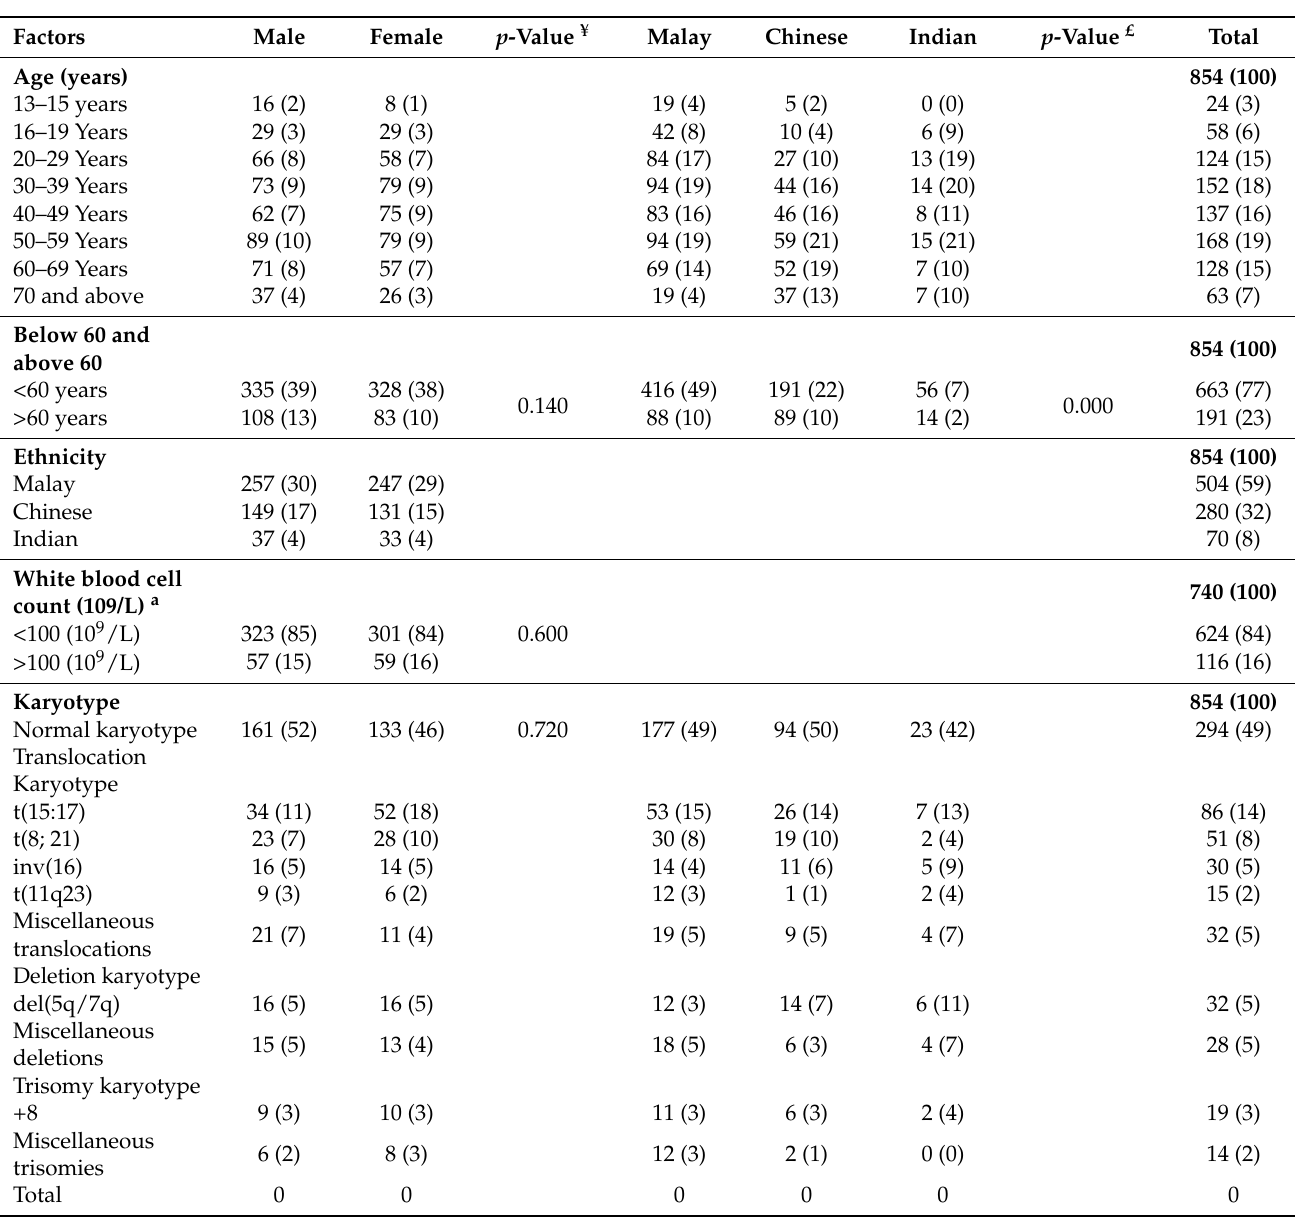
Table 1. The distribution of cytogenetic profiles based on gender, age, group, and ethnicity are depicted in Figures 1–3. Table 1. Summary on gender, Moorman’s classification, 2017 ELN stratification, and age by decade distribution among the ethnic groups (number